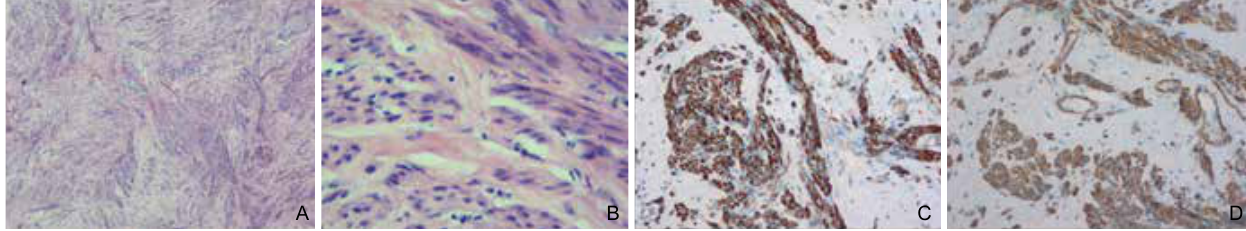
A B C Figure 4 Histopathology showing whorls of smooth muscle fibres under 10× (A) and 40× (B) microscope. Immunohistochemical stain for smooth muscle desmin (C) and SMA (D).